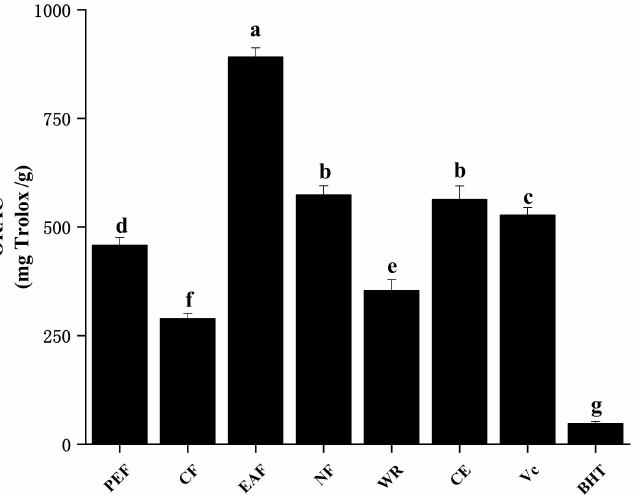
Figure 4. The oxygen radical absorbance capacity of samples. The different letters in the column represented significantly difference ( p <